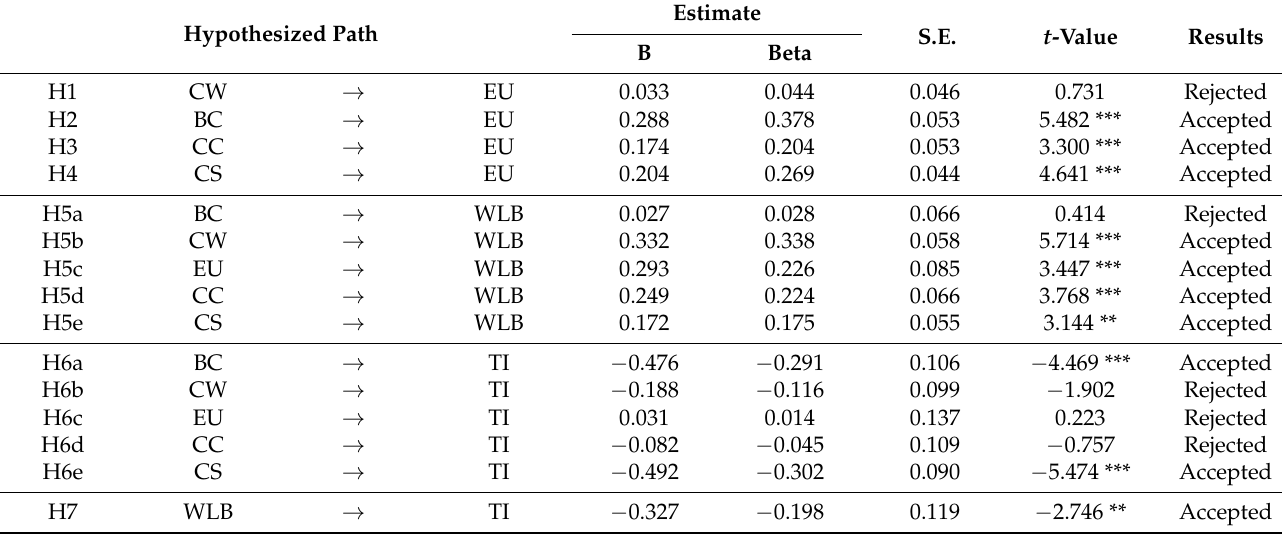
Table 4. Results of structural equation modeling.